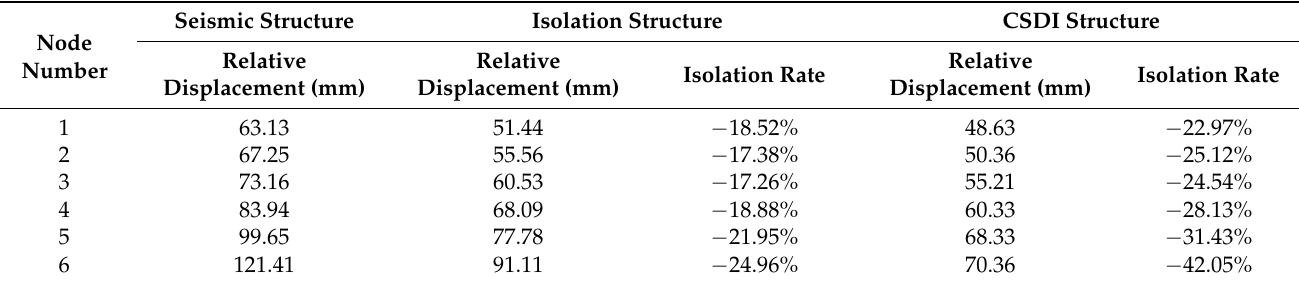
Table 4. Seismic response comparison of superstructure.